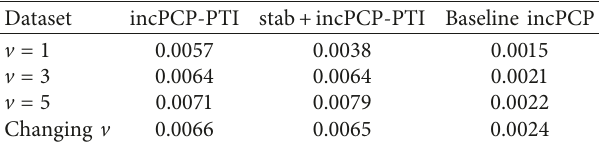
Table 7: Value of average distance M ( s stab+incPCP-PTI, and baseline incPCP (Section 4.1) on the SPJ